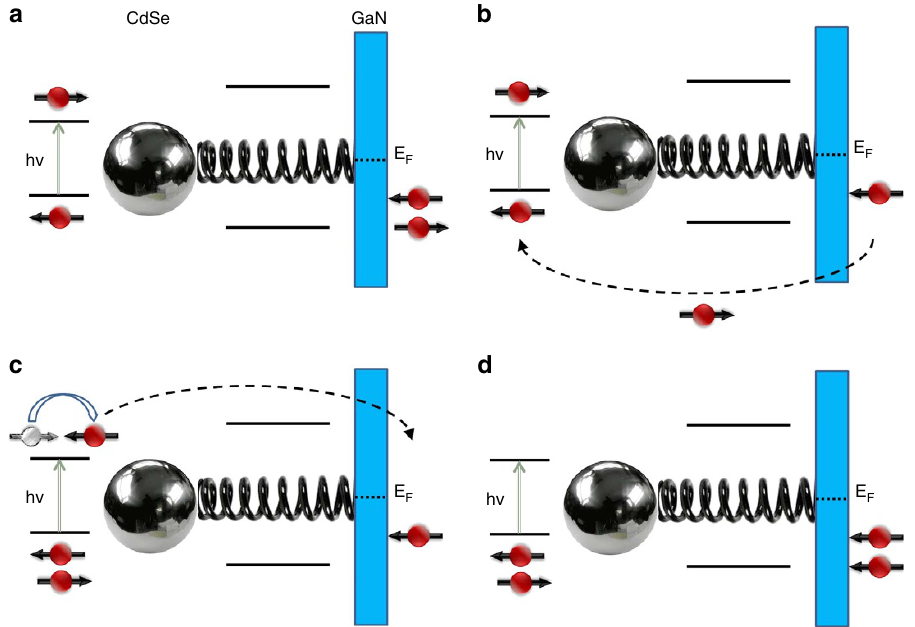
Figure 6 | A schematic explanation of light-induced spin polarization at a semiconductor substrate adsorbed by nanoparticle (NP) bearing chiral molecules. ( a ) Photoexcitation of the NPs creates an electron–hole pair. ( b ) A spin-selected electron is transferred from the substrate to the hole on the NP. An unpaired electron is left on the substrate side. ( c ) Following spin randomization of the excited electron on the NP, this electron is transferred to the substrate. Both NP and substrate are again neutral. ( d ) A net spin polarization at the substrate is formed. This process may occur many times during the substrate spin-polarization lifetime, resulting in very high polarization. Depending on rate constants involved, step ( c ) may precede ( b ).